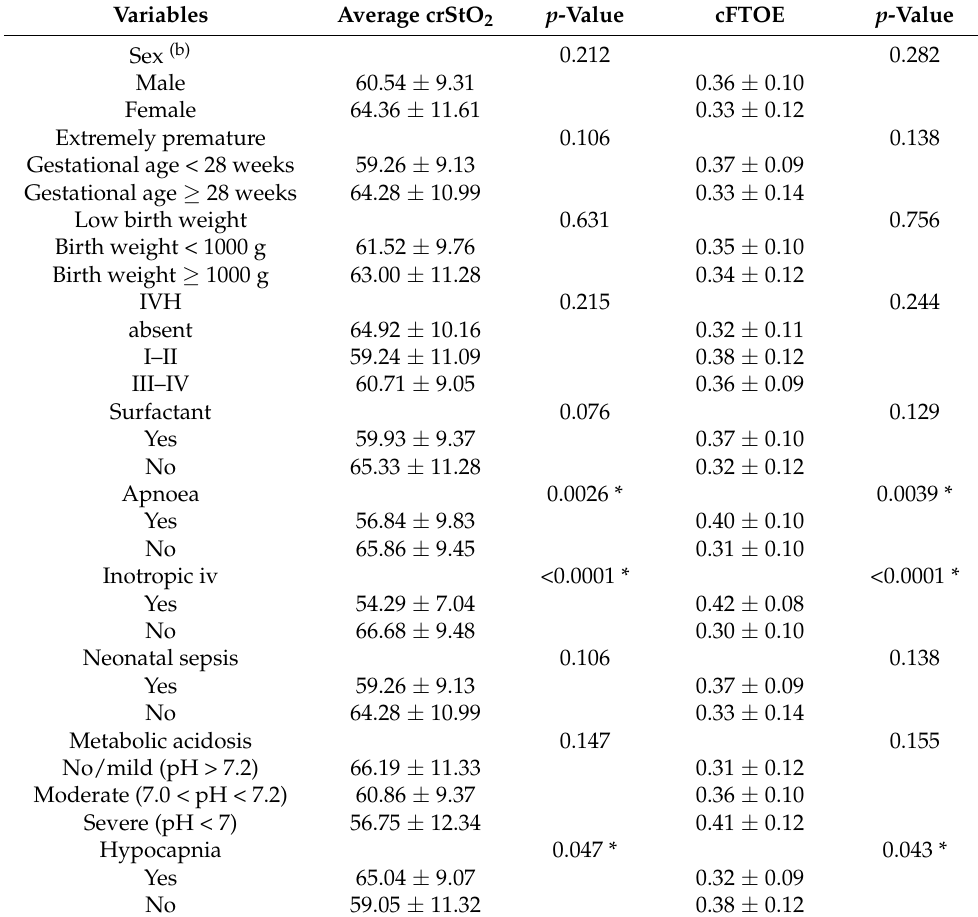
Table 2. Associations of cFTOE and crSaO 2 with clinical characteristics of premature neonates. Variables Average crStO 2 p -Value cFTOE Sex (b)